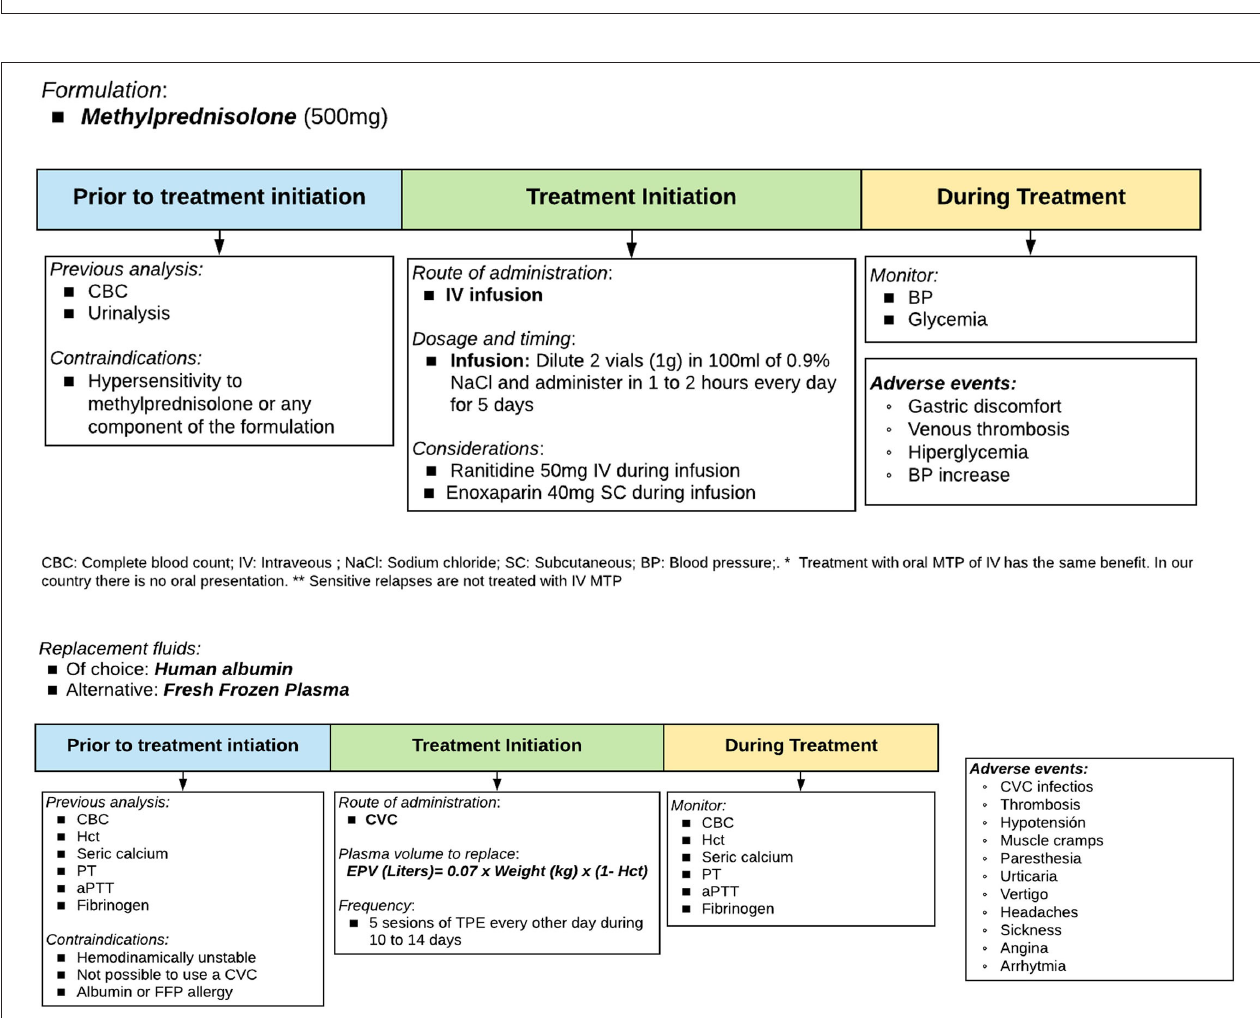
FIGURE 2 | Therapeutic protocol for relapses: Methylprednisolone and therapeutic plasma exchange. Source: Authors.